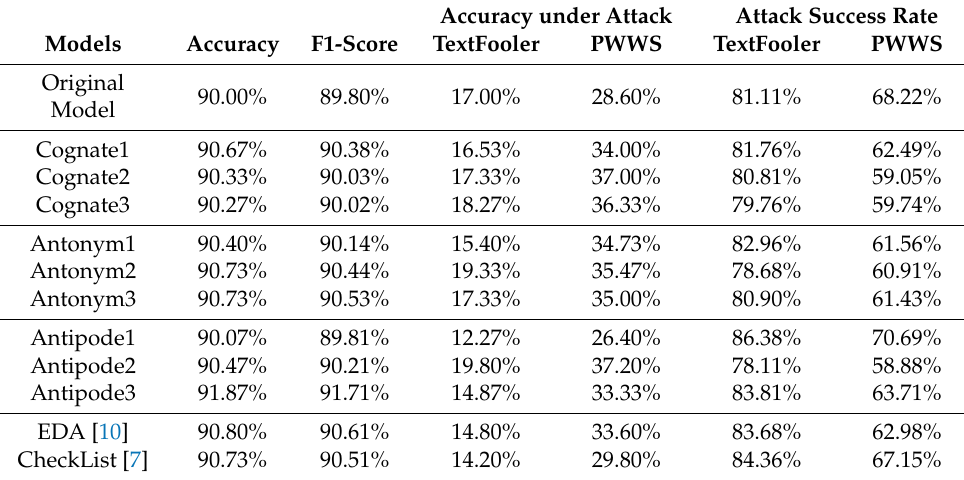
Table A1. AG-News Performance and Robustness